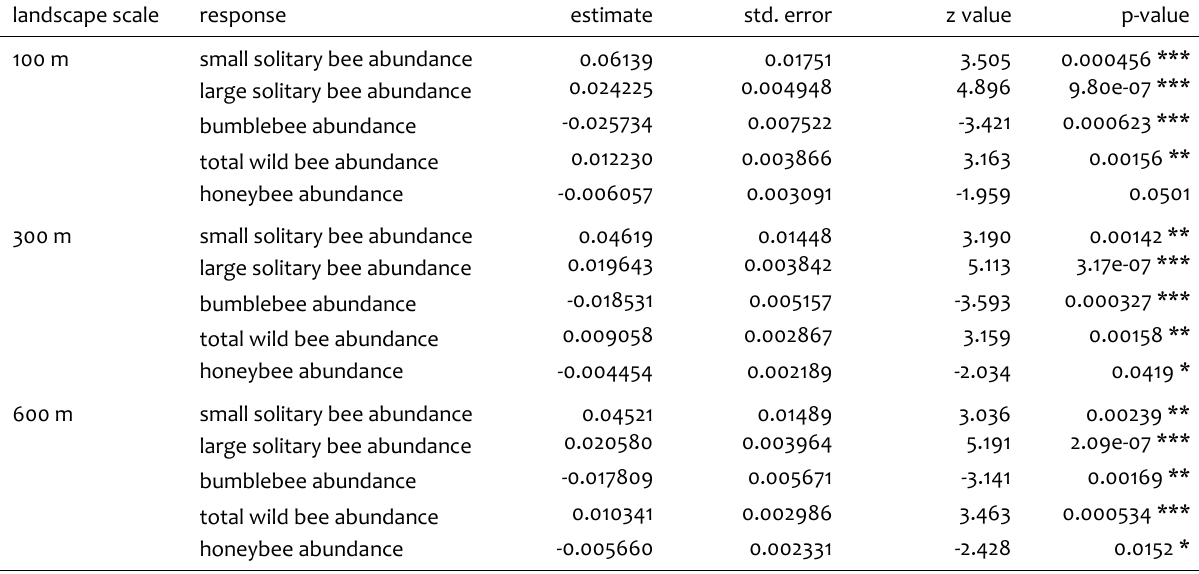
Table 7. Results of poisson regression models assessing the effect of the proportion of urban habitat around each site on wild bee and honeybee abundance on apple flowers. Each landscape scale and bee type represent a separate model. Estimated parameters, standard errors, z-values and p-values are given. Significance is marked with * at P  0.05, ** at P  0.01 and *** at P 